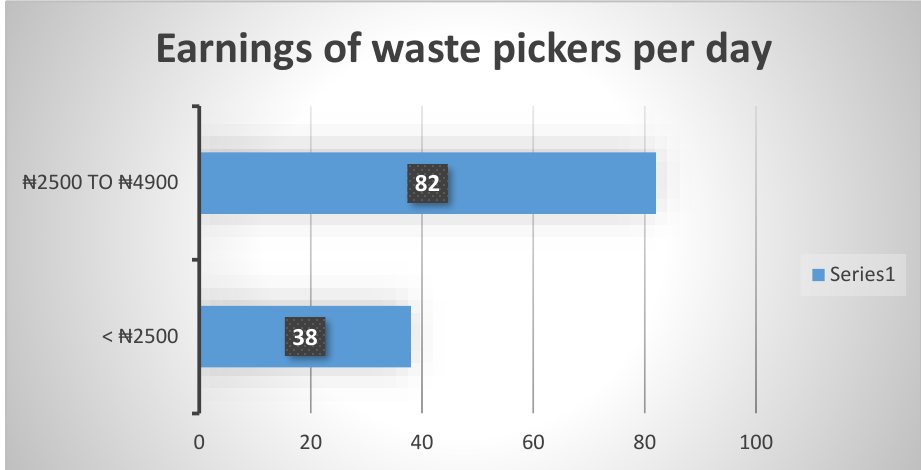
Figure 5. Earnings of waste pickers in Lagos State, Nigeria. Source: Computed by authors.